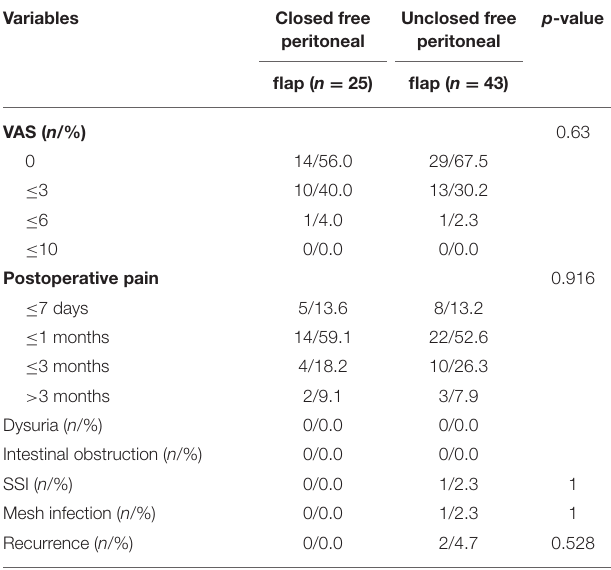
TABLE 7 | Comparison of postoperative VAS score, pain days, recurrence and other complications.